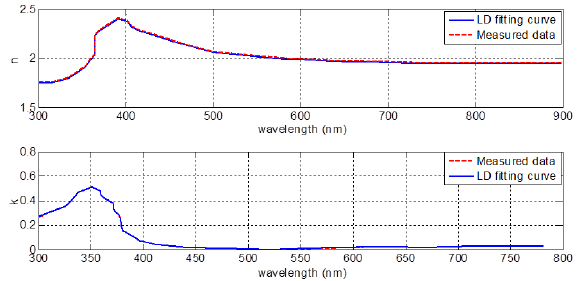
Figure 5. LD fitting curves for the real and the imaginary parts of the Al permittivity using experimental data in [5].